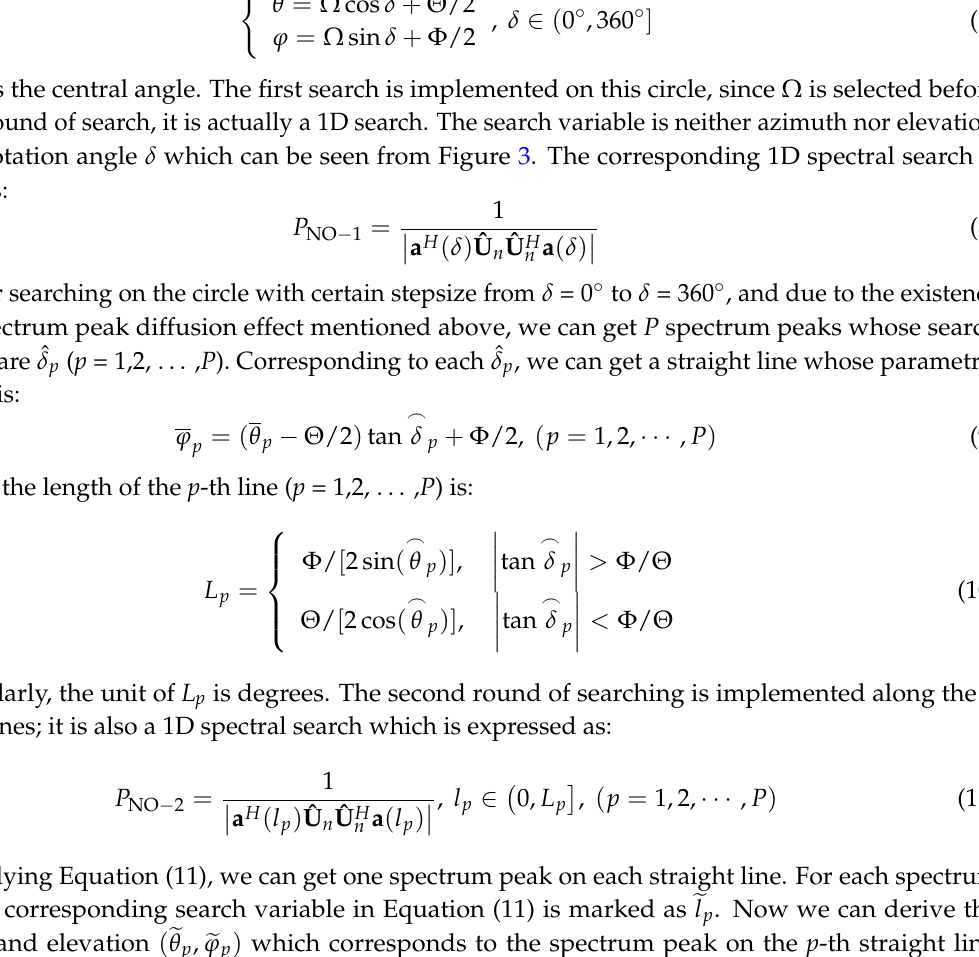
Figure 3. Proposed search scheme. *